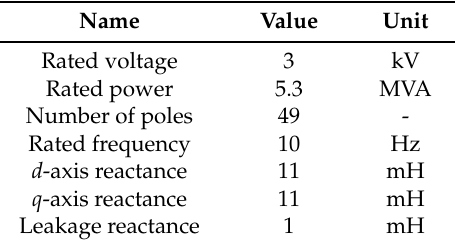
Table 2. Definition of the variables used in the PMSG simulation model.